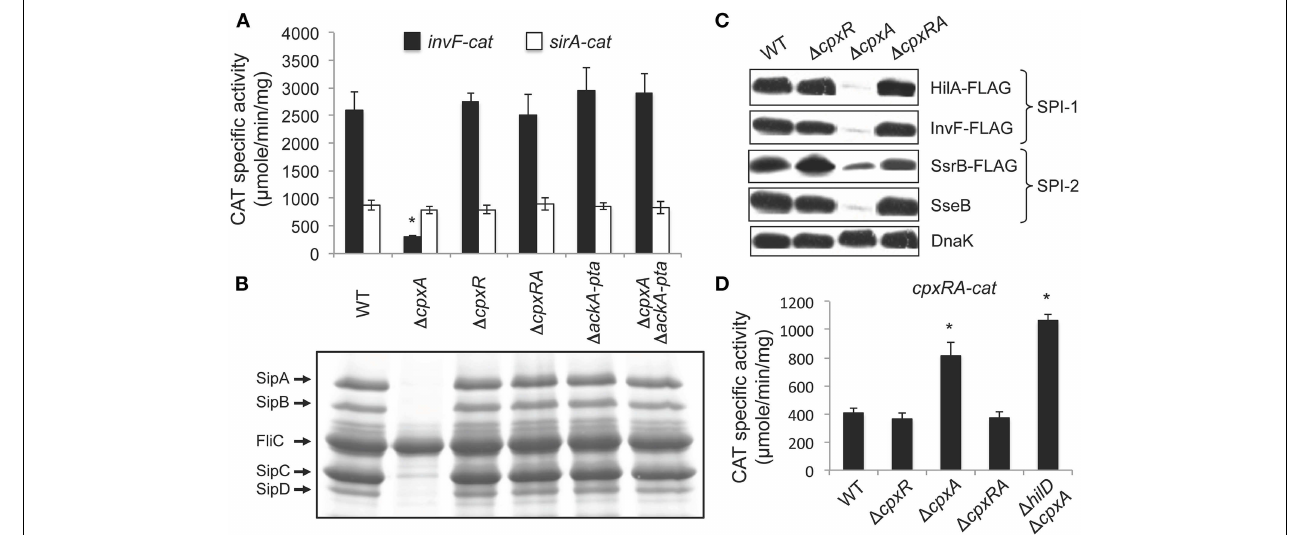
FIGURE 1 | The absence of CpxA represses SPI-1 genes by the activation of CpxR via the AckA and Pta enzymes. (A) Expression of the invF-cat and sirA-cat transcriptional fusions, carried by plasmids pinvF-cat and psirA-cat, respectively, was tested in the WT S . Typhimurium 14028s strain and its isogenic 1 cpxA , 1 cpxR , 1 cpxRA , 1 ackA-pta , and 1 cpxA 1 ackA-pta mutants. (B) Secretion analysis of the SPI-1-encoded proteins SipA, SipB, SipC, and SipD was tested in the WT S . Typhimurium strain 14028s and its isogenic 1 cpxA , 1 cpxR , 1 cpxRA , 1 ackA-pta , and 1 cpxA